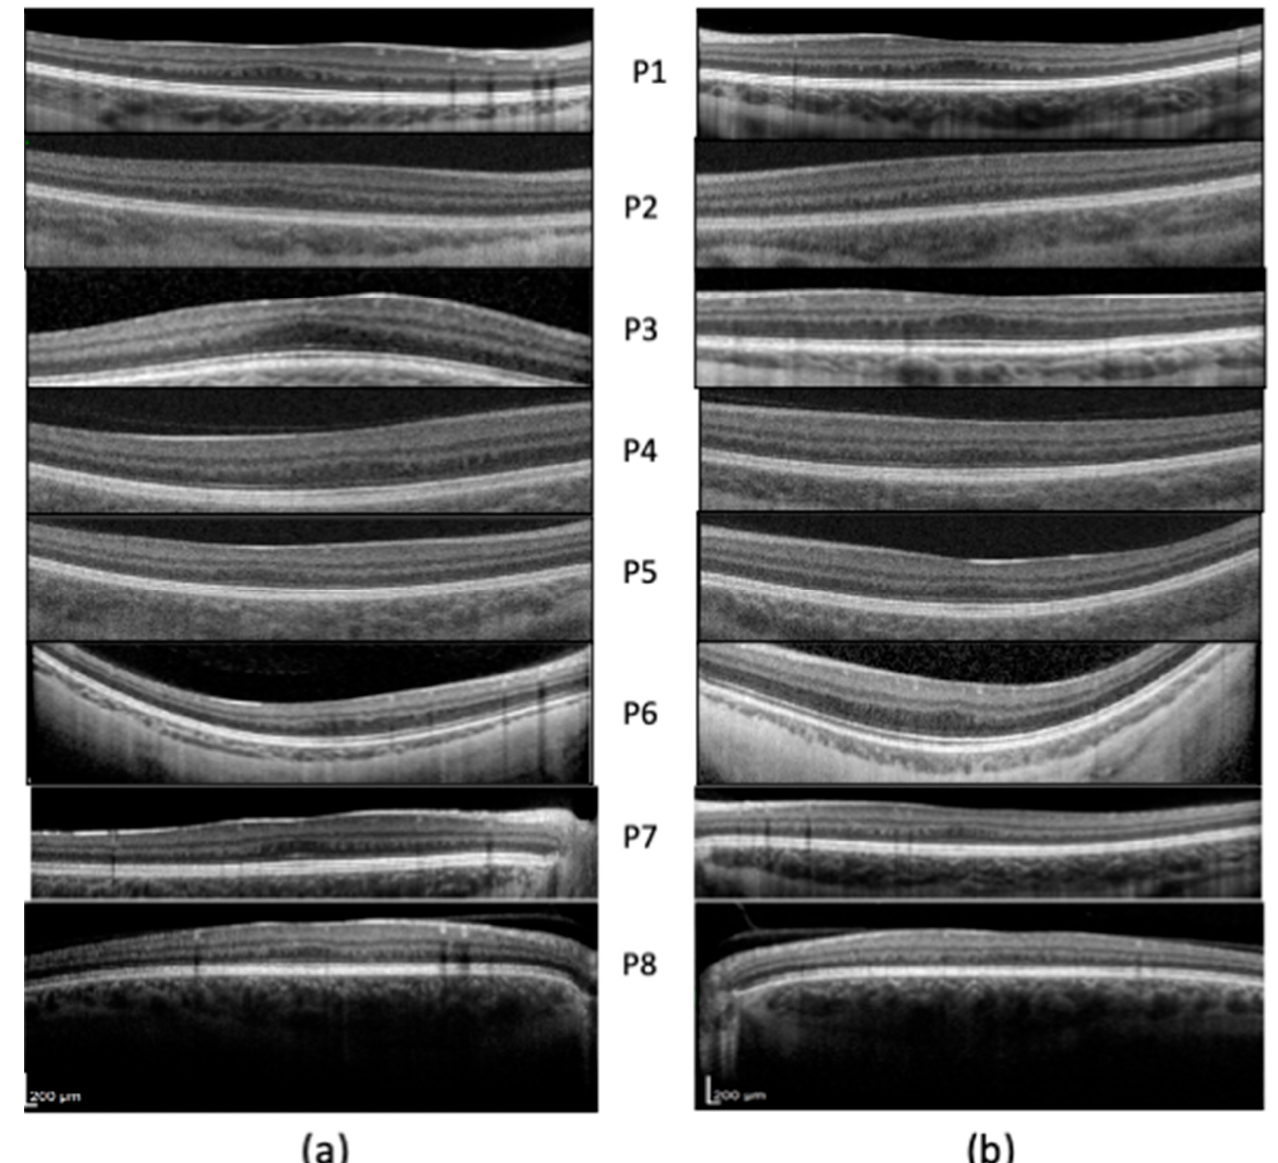
Figure 1. Structural SD-OCT examination: note the different degrees of foveal hypoplasia (refer to Table 1 for grading). ( a ) Right eye. ( b ) Left eye.